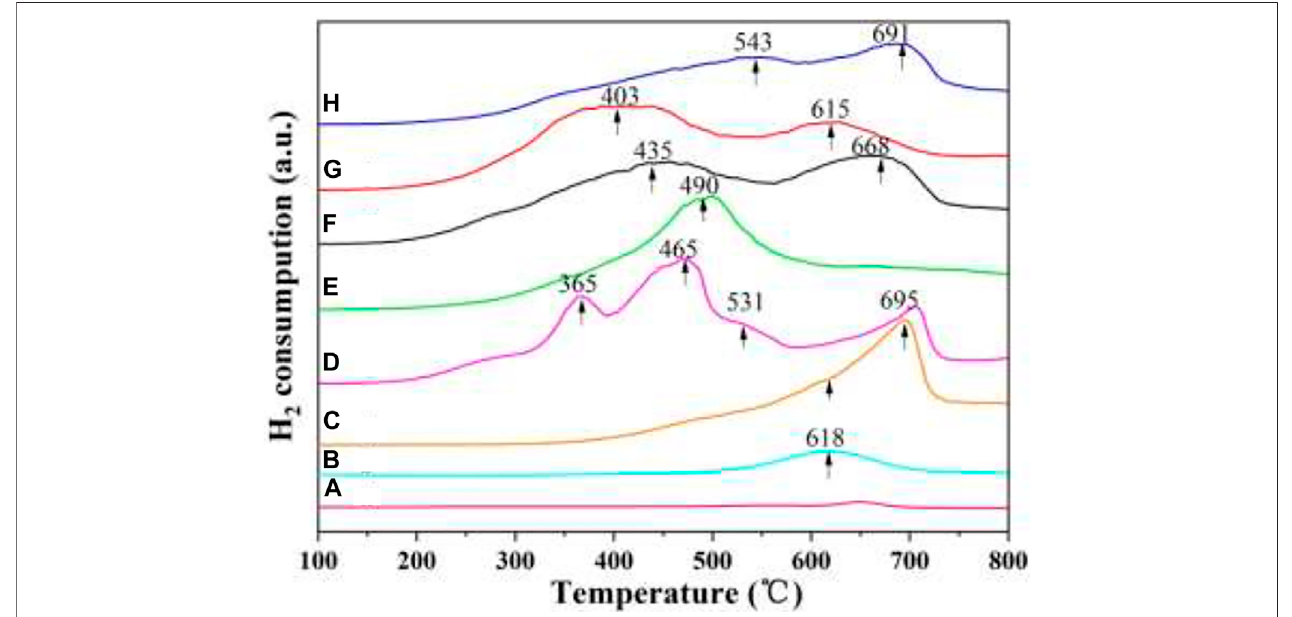
FIGURE9| H 2 -TPRpro fi lesofthe3DOMcatalysts. (A) ZrTiO 4 ; (B) CeO 2 /ZrTiO 4 ; (C) W 1 CeO δ /ZrTiO 4 ; (D) W 1 MnO δ /ZrTiO 4 ; (E) W 1 CeMnO δ /TiO 2 ; (F) W 0.5 CeMnO δ / ZrTiO